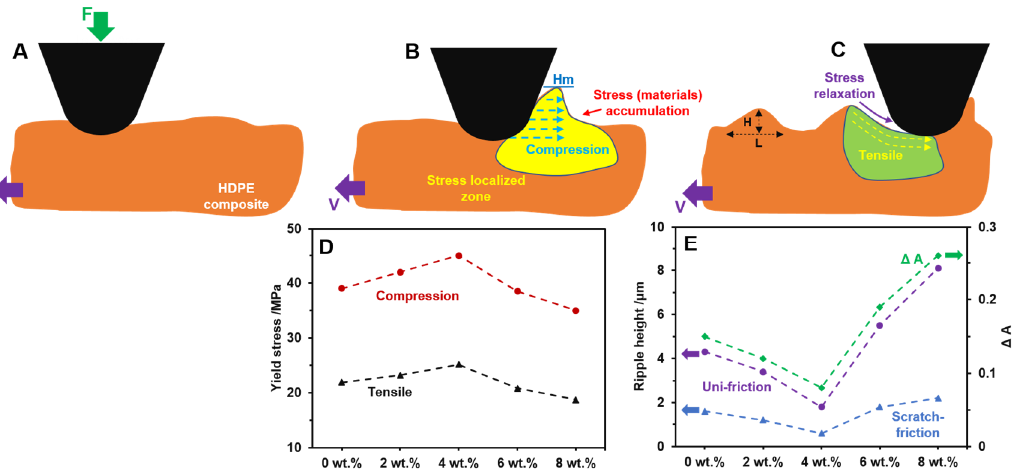
Figure 9. ( A – C ) graphically represent ripple deformation during the single-asperity scratch test; ( D , E ) show the relationships between the addition of Si 3 N 4 and the intrinsic mechanical properties, the ripple, and COF responses.